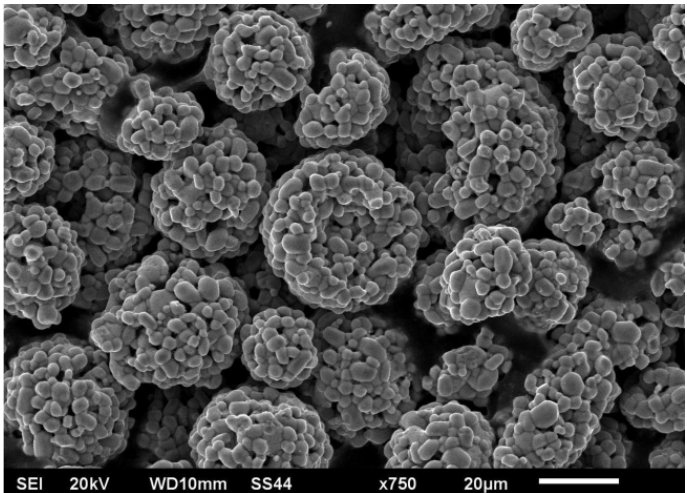
Figure 1. Grains of the Cr 3 C 2 –NiCr powder. The surface of the Cr 3 C 2 –NiCr coating (obtained by scanning electron microscopy) before the laser alloying process is shown in Figure 2.